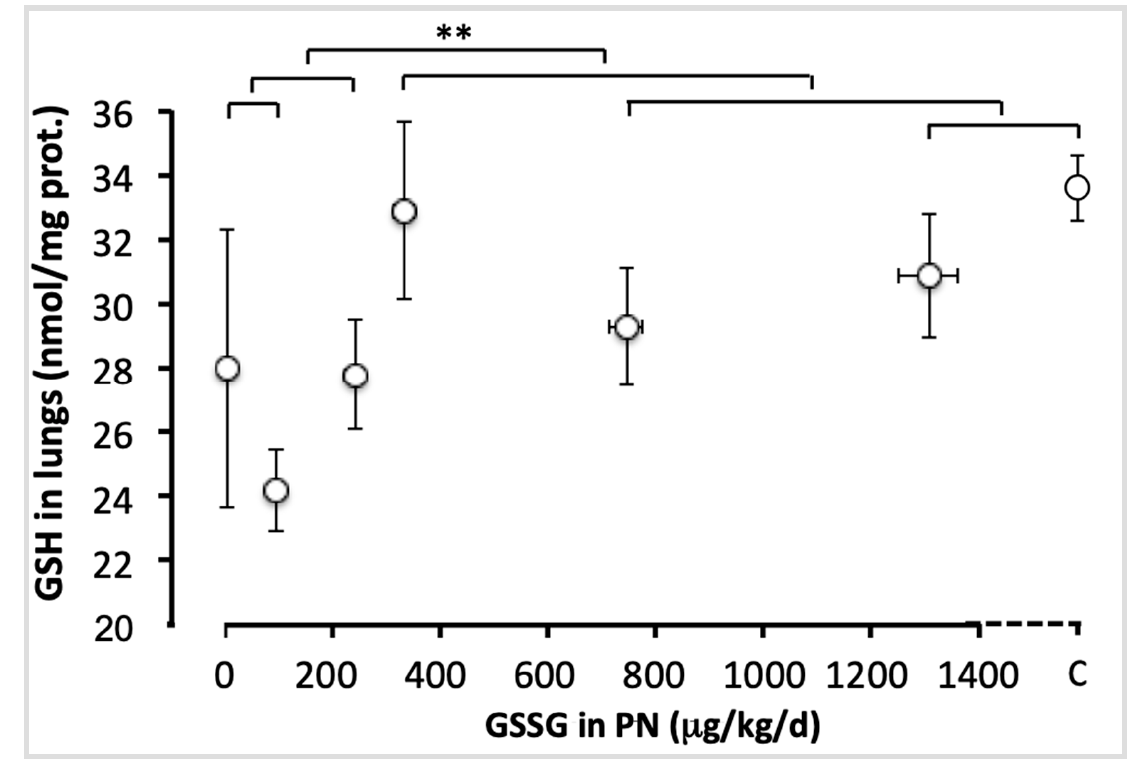
Figure 3. Pulmonary GSH levels as a function of increasing doses of GSSG added to PN. The control (C) value was added to the abscissa after the highest dose of GSSG. The orthogonal comparisons were 0 vs. 95 µg/kg/d (no statistical difference), both vs. 240 µg/kg/d (no difference). The highest dose (1300 µg/kg/d) was not statistically different from the control, the two were not different from 750 µg/kg/d, nor from 330 µg/kg/d. The highest doses (330 to 1300 µg/kg/d) and the control were statistically different ( p < 0.01) from the lowest doses (0 to 240 µg/kg/d). Mean ± S.E.M. for GSH values ( y axis) and doses ( x axis). The bars indicate the orthogonal comparisons; the absence of significant difference is shown by the absence of symbol above the bar; **: p < 0.01; n = 6–11 per group.